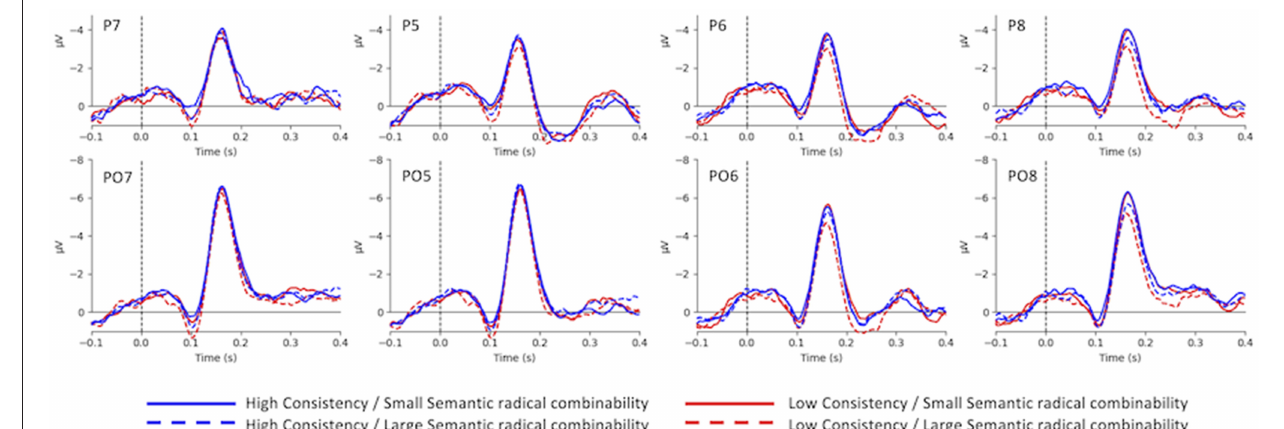
FIGURE 2 | The grand-average waves of N170.